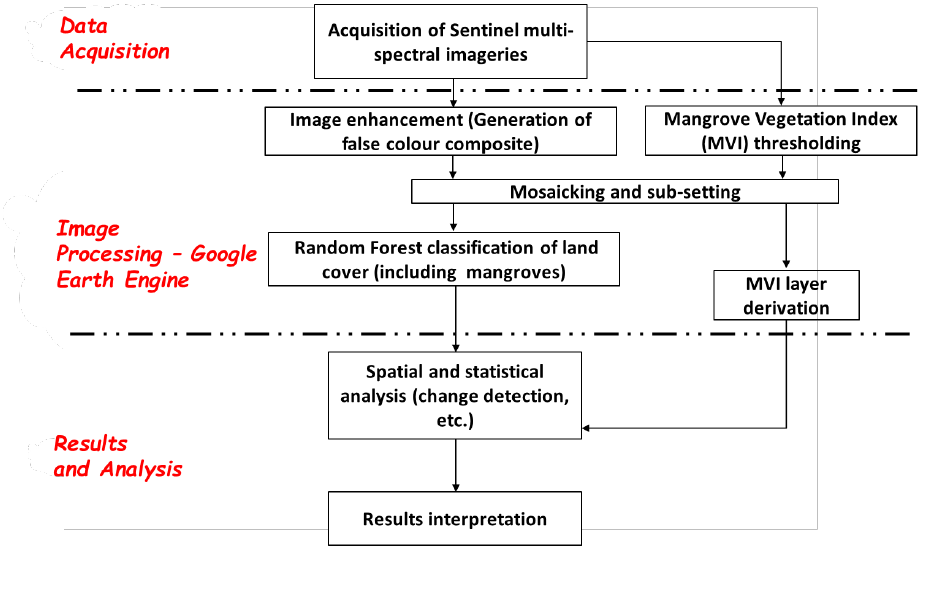
Figure 1 . Methodology